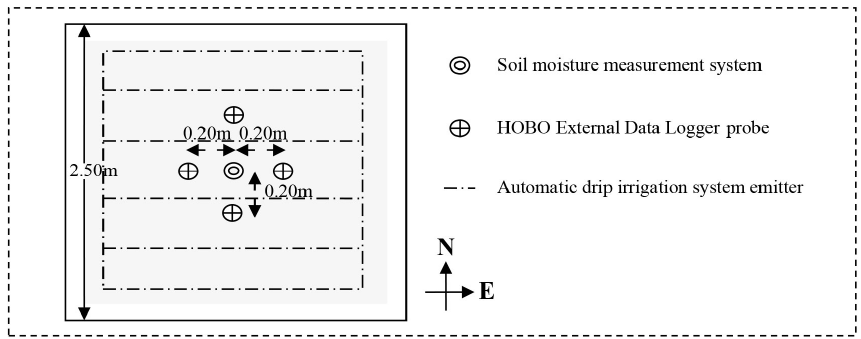
Figure 2. Layout of automatic observation instruments in each plot.